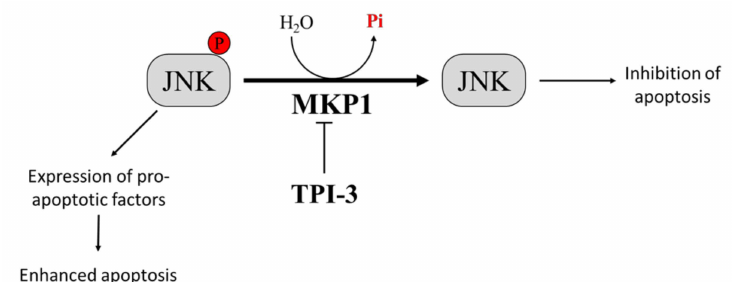
Figure 2. E ff ect of Mitogen-Activated Protein Kinase Phosphatase-1 (MKP1) targeting on melanoma cells. Overexpression of MKP1 phosphatase in melanoma cells contributes to enhance resistance toward anticancer drugs. For this reason, MKP1 inhibition is su ffi cient to enhance cancer cell death in culture and to sensitize cancer cells towards cytotoxic drugs. Among the substrates of MKP1, there is JNK. MKP1 dephosphorylates JNK, inhibiting its activation, and thereby avoiding